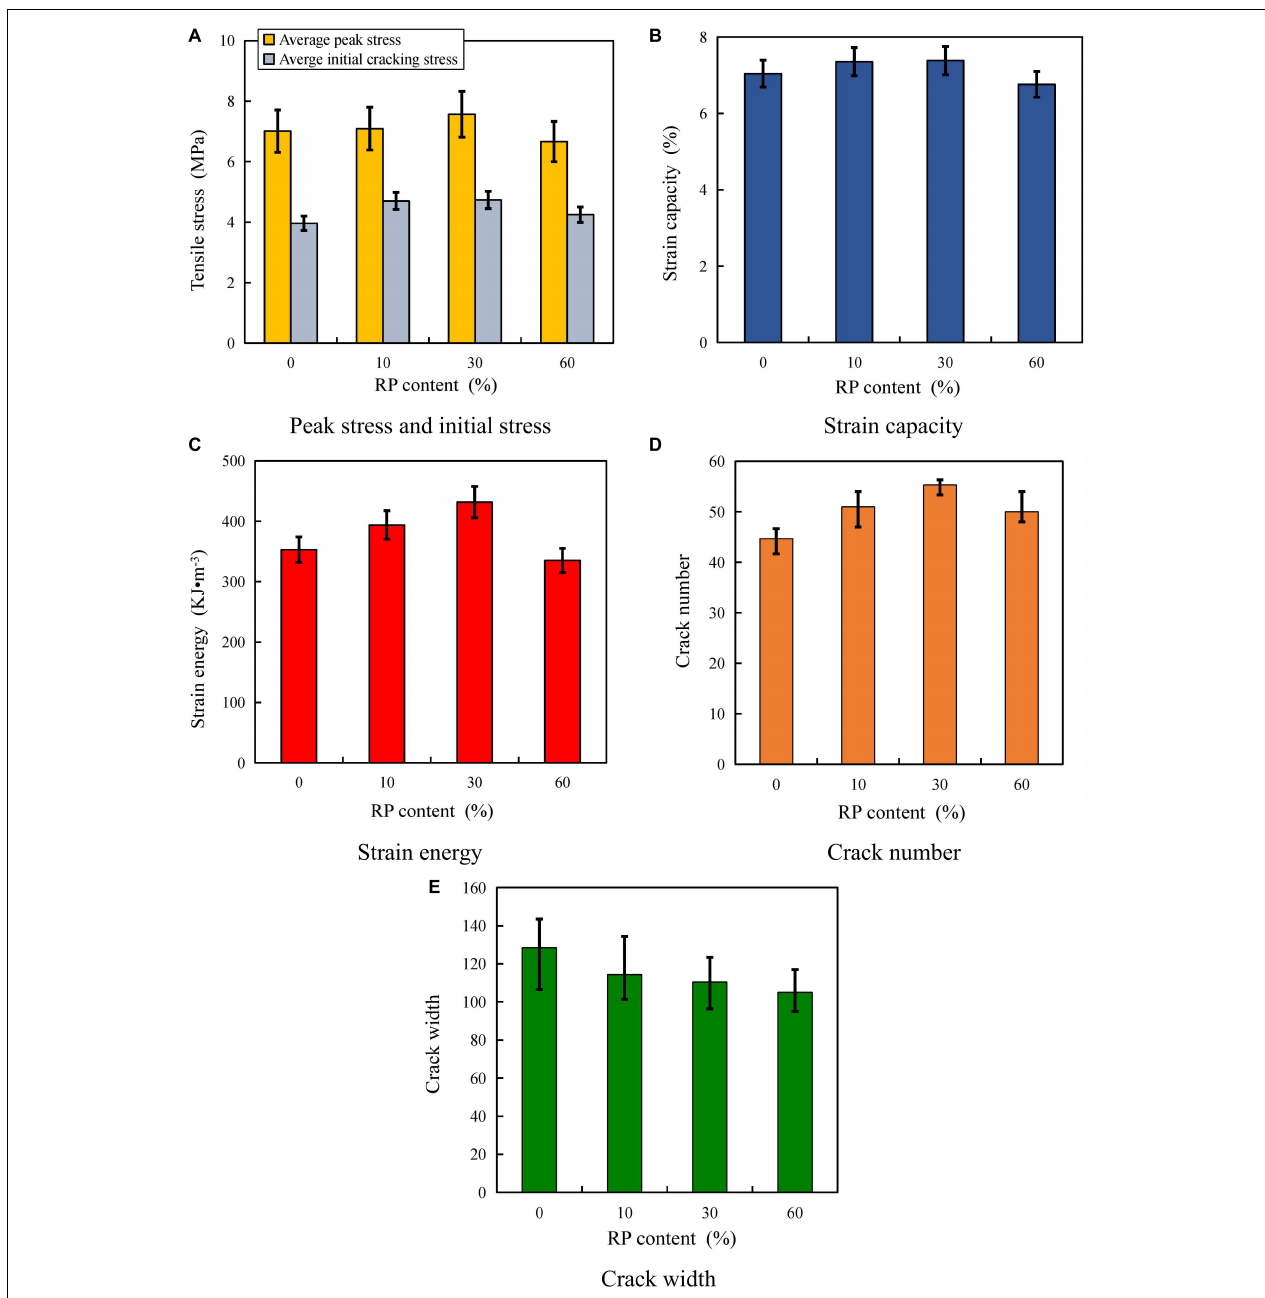
FIGURE 11 | Tensile parameters of HDCCs with different RP replacement ratios. (A) Peak stress and initial stress. (B) Strain capacity. (C) Strain energy. (D) Crack number. (E) Crack